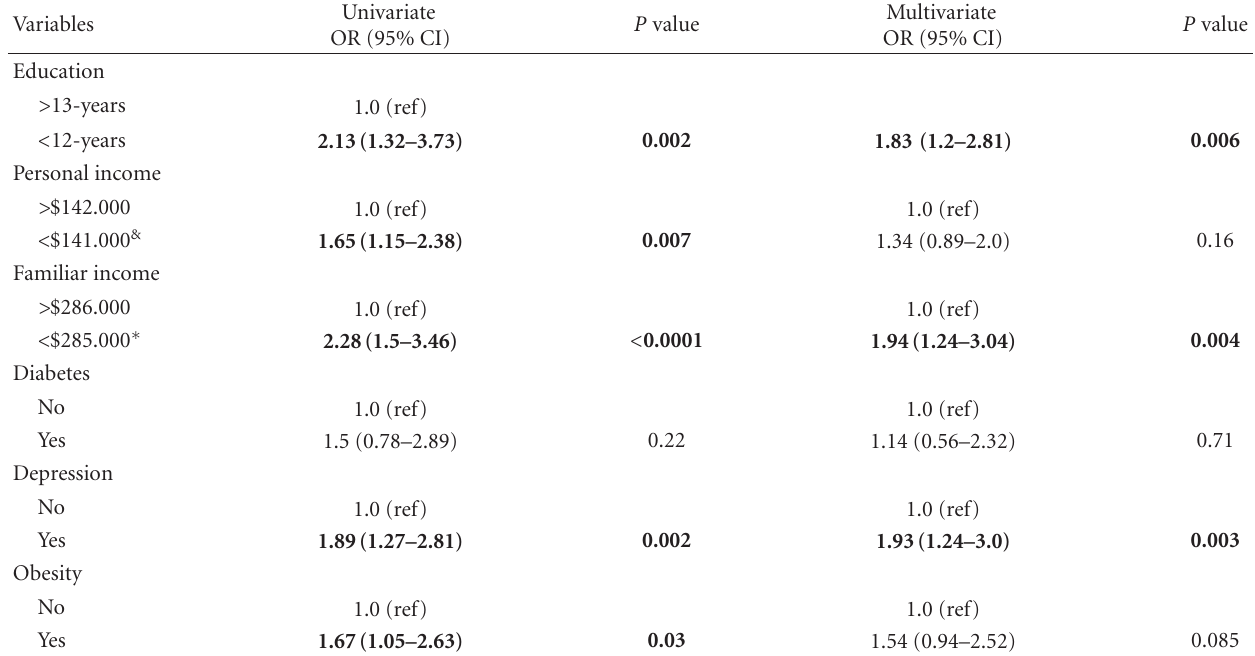
Table 4: Non-adjusted and adjusted odds ratios (ORs) and 95% confidence interval (95% CI) related to tooth loss (the presence of less than 21 teeth in mouth) for the 35–44-year-old